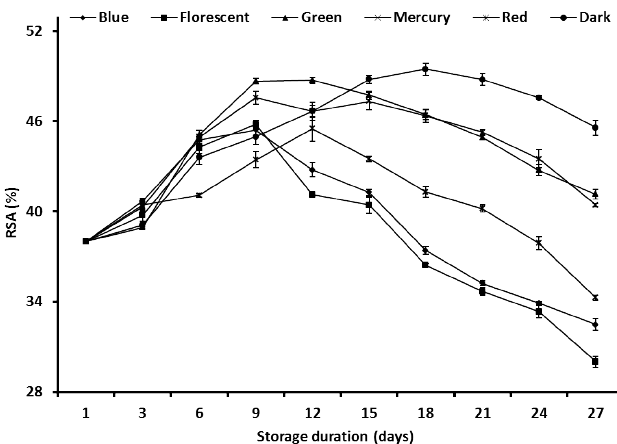
Fig. 8: Effect of different light sources on radical scavenging activity (%). Vertical bars show ±SE of means (n=3). The interaction between storage duration and light sources was significantly different at p ≤